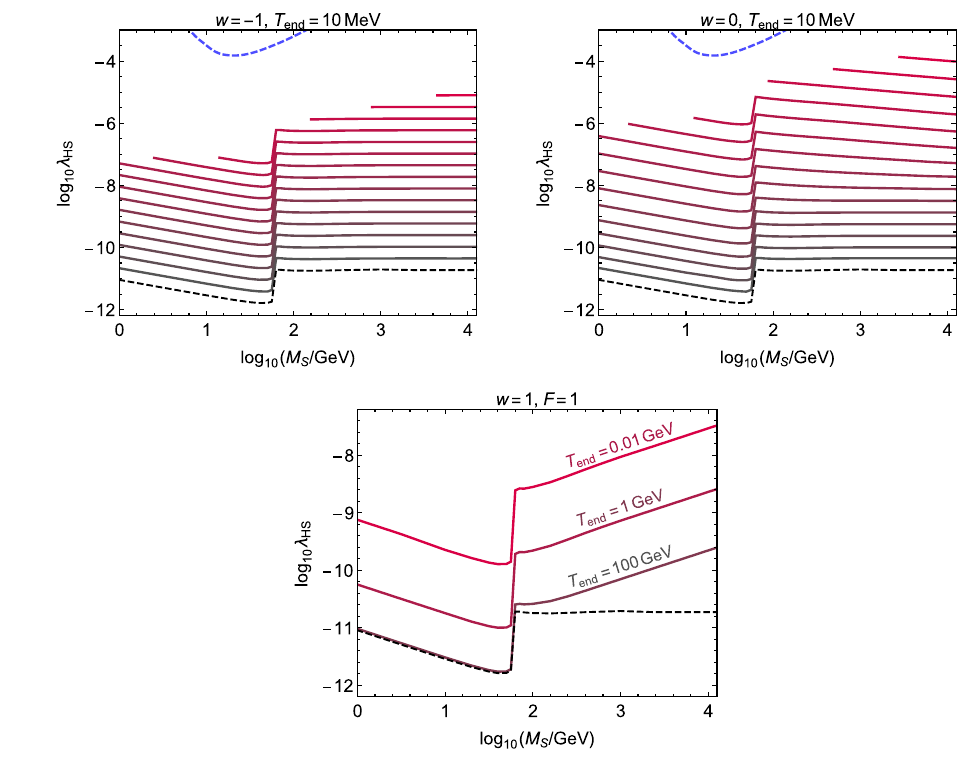
Fig. 4 The curves show the value of λ HS for which the observed DM abundance in S particles is obtained via freeze-in for different expansion histories with w = − 1, 0, 1. In the top panels the solid lines correspond to log 10 F = 1, 2…15, from bottom to top. For large values of F and small M S , the freeze-in picture is not consistent (thermalization with the SM is reached), which introduces a cut-off to the corresponding curves. The black dashed curve in the bottom of each panel shows the result in the standard radiation dominated case. The region above the blue curve is expected to be probed by DARWIN, if all DM is in S